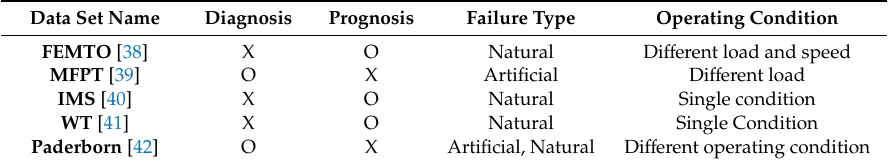
Table 5. Open Data for Fault Diagnosis and Prognosis of